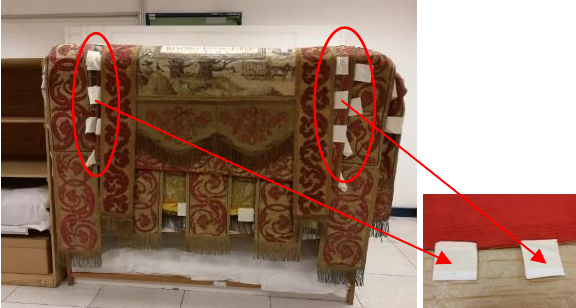
Figure 14 (left) - Banners with the textile strips extensions. And textile strips extensions, squared shape, with Velcro strip on the top of the side faced to the back of the banner (right). In some banners the pendants and fringes also exceeded the height of the grids. In these cases and following the original model (Figure 15) besides sewing the textile strip extensions we also applied textile loops on the back of the pendants, to be folded and fixed directly to the metal grilles with a textile tape (Figure 16).